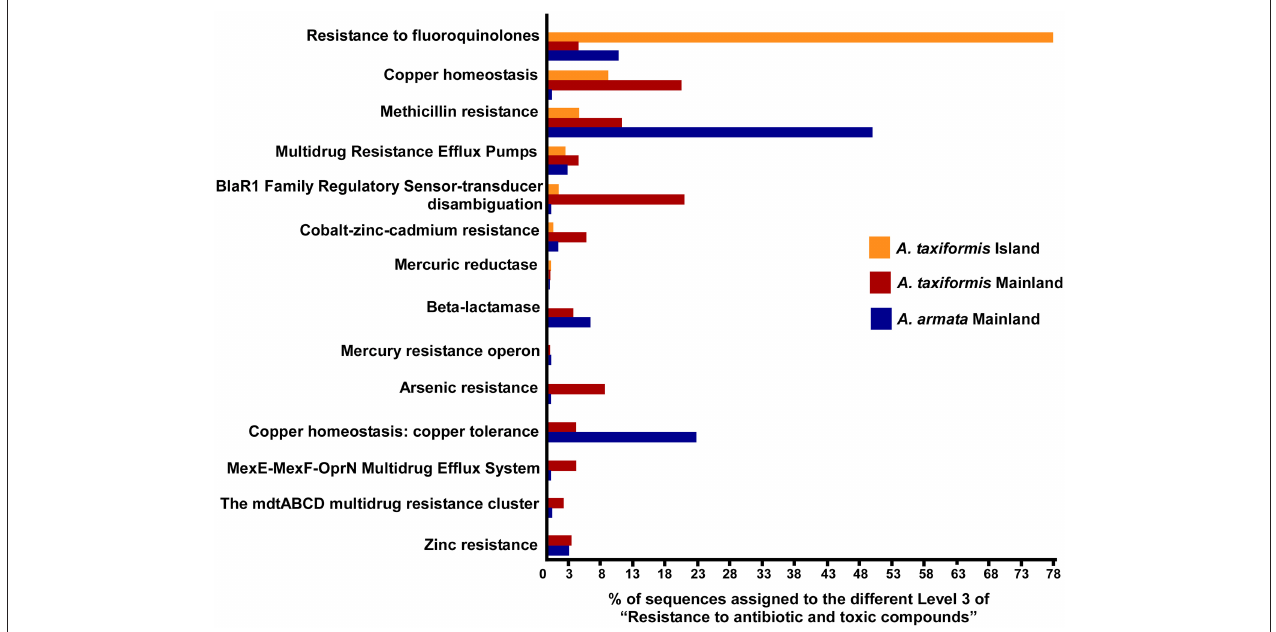
FIGURE 5 | Percentage of metagenomic sequences of functional composition of Level 2—Resistance to antibiotic and toxic compounds (assigned to the general SEED subsystems)—of Asparagopsis sps. from Mainland and Island (Raw data in Table S6).